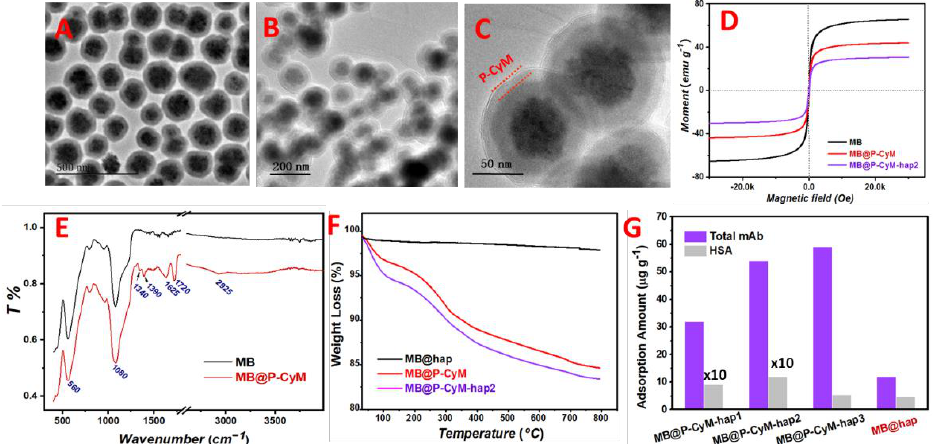
Figure 1. TEM images of the MB ( A ), the MB@P-CyM ( B ) and the zoomed-in image of the MB@P- CyM ( C ); ( D ) FT-IR spectra and ( E ) TGA curves as well as ( F ) the magnetization measurements of different modified MBs; ( G ) Evaluation of the binding and the non-specific adsorption characters for different hapten-modified MBs.